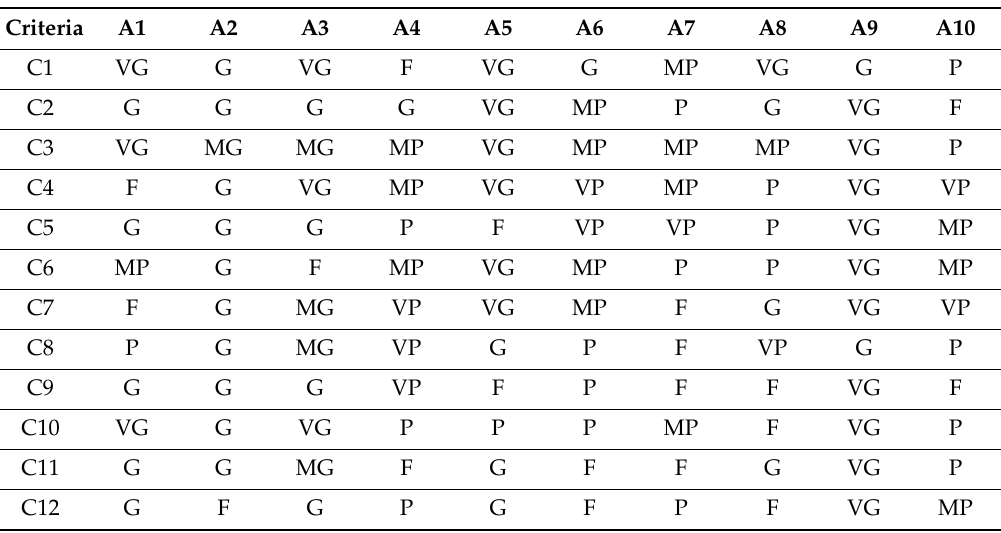
Table 6. Decision maker 1 (DM1) evaluates the